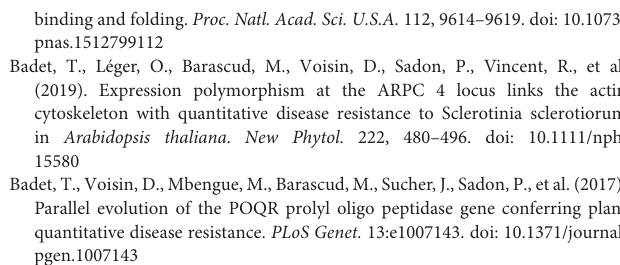
FIGURE S1 | Genomic distribution and synteny analysis of DUF4228 genes in A. thaliana . For each gene, the phylogenetic clade and the level of expression (log 2 fold change) upon infection by S. sclerotiorum is provided. Genes significantly differentially expressed upon infection are indicated with a star ( ∗ ). Lines in the center of the graph show PADRE synteny blocks. The quartet AT2G23690/AT4G37240/AT5G66580/AT3G50800 is reported as two gene pairs in Yang et al. (2020), the quartet AT1G71015/AT2G01340/AT1G66480/AT5G 37840 was not associated with gene duplication by Yang et al. (2020). FIGURE S2 | Modularity of genes included in the AtPADRE co-expression network. Genes with values higher than average are labeled on the graph. Boxplots show first and third quartiles (box), median (thick line) and the most dispersed values within 1.5 times the interquartile range (whiskers). TABLE S1 | PFAM domains enriched in genes induced upon S. sclerotiorum inoculation. TABLE S2 | Expression of 24 PADRE genes from A. thaliana under a range of biotic and abiotic stress, with mention of their inclusion in the list of genes upregulated upon S. sclerotiorum inoculation, down-regulated upon S. sclerotiorum inoculation and top 10% most induced genes after infection by S. sclerotiorum . TABLE S3 | Expression of 74 PADRE genes from A. thaliana , S. lycopersicum and R. communis upon S. sclerotiorum inoculation determined by RNA